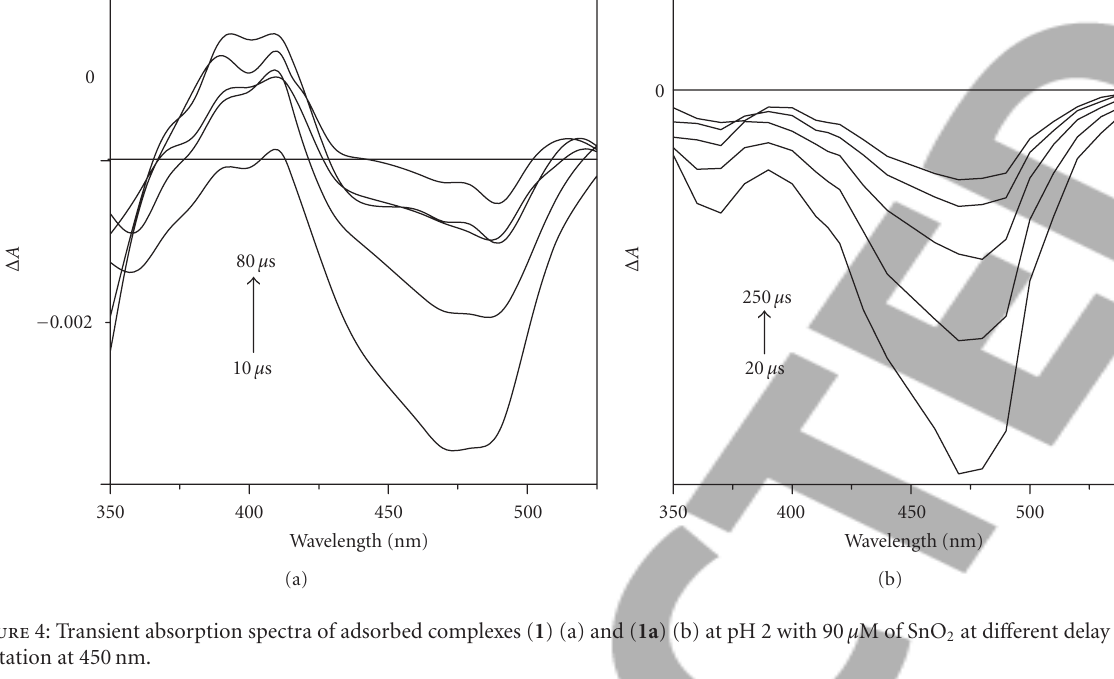
Figure 4: Transient absorption spectra of adsorbed complexes ( 1 ) (a) and ( 1a ) (b) at pH 2 with 90 μ M of SnO 2 at di ff erent delay times after excitation at 450 nm.